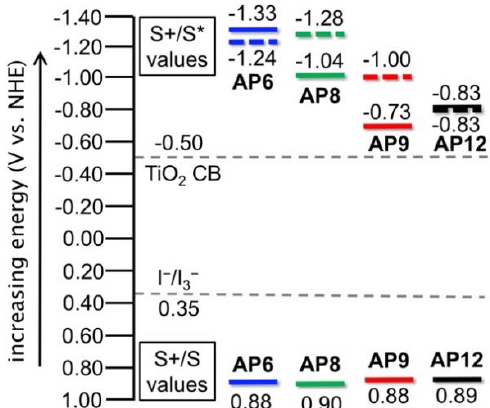
Figure 3. Energy level diagram for AP6 , AP8 , AP9 , and AP12 in DCM (solid bars) and on TiO 2 (dashed bars). The S+/S values change by <0.02 V on TiO 2 when compared with the solution values shown in the figure.